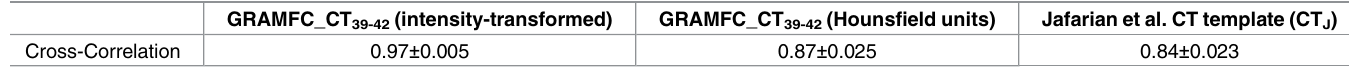
Table 2. Mean and standard deviation of cross-correlation between 45 image pairs after registration to GRAMFC_CT 39-42 and CT J . GRAMFC_CT 39-42 (intensity-transformed)